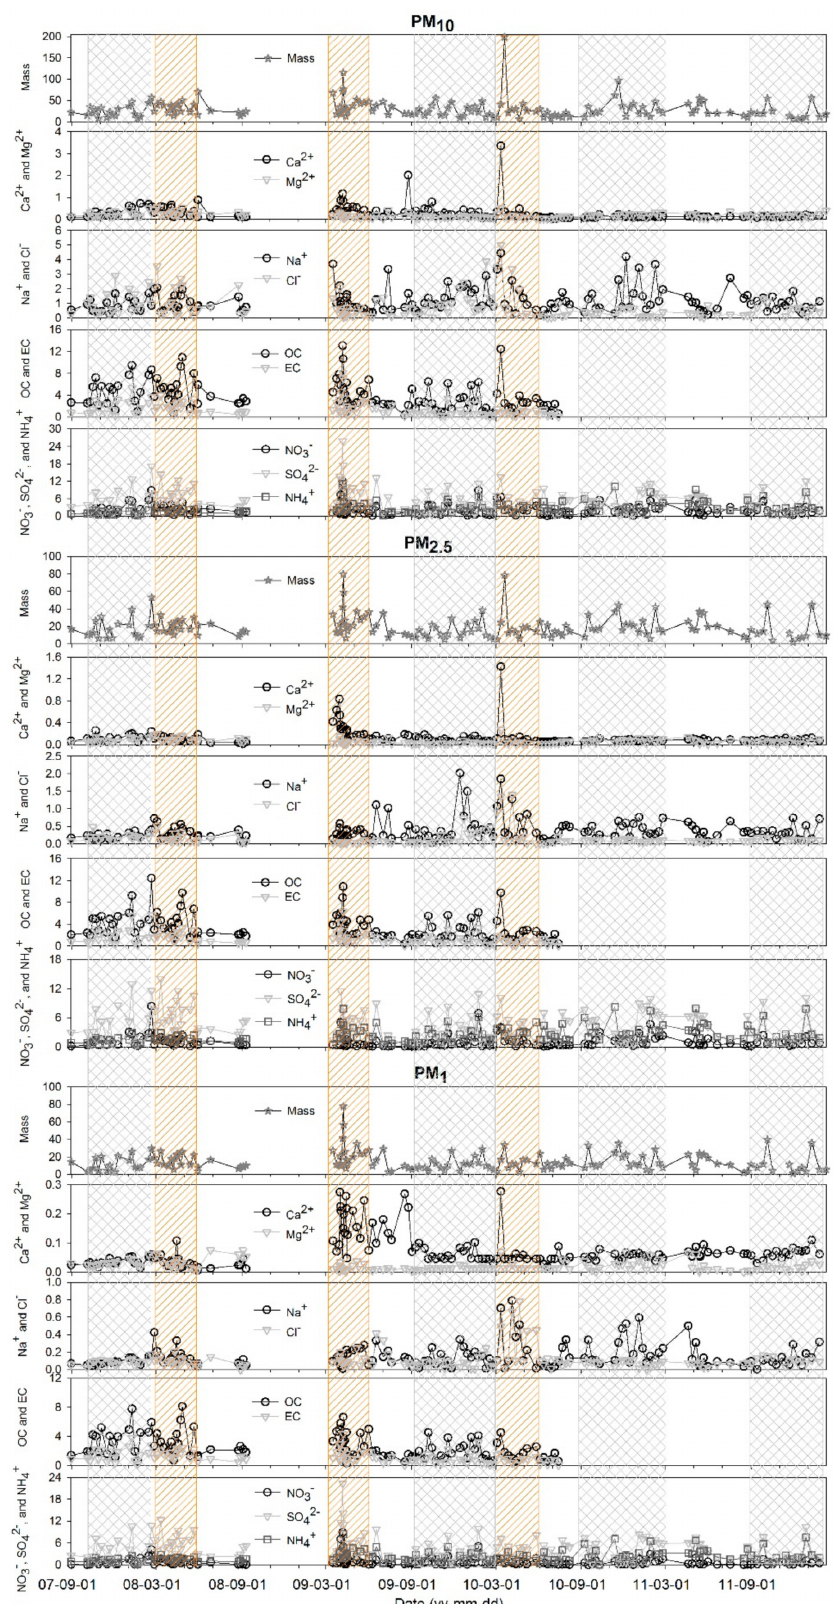
Figure 2. Temporal variations of major constituents of PM 10 , PM 2.5 , and PM 1 for the August 2007~February 2012 period ( µ g/m 3 ). Spring (March to May) and winter (December to February) periods are shaded in orange and gray,